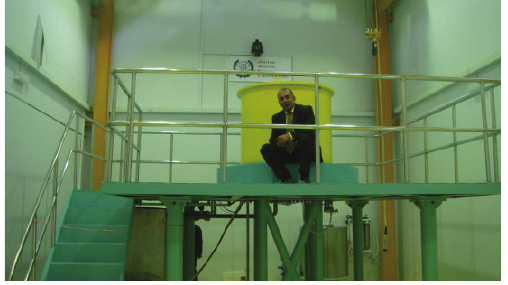
Figure 1: Reactor hall of Jordan Subcritical Assembly (JSA).